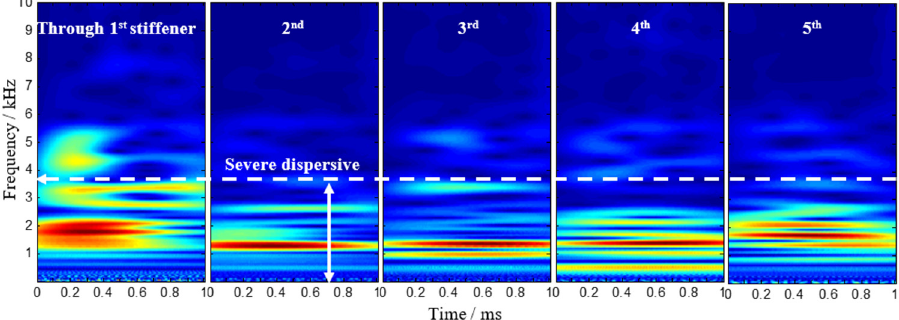
Figure 4. Continuous wavelet transforms on typical outputs of the PZT sensors.